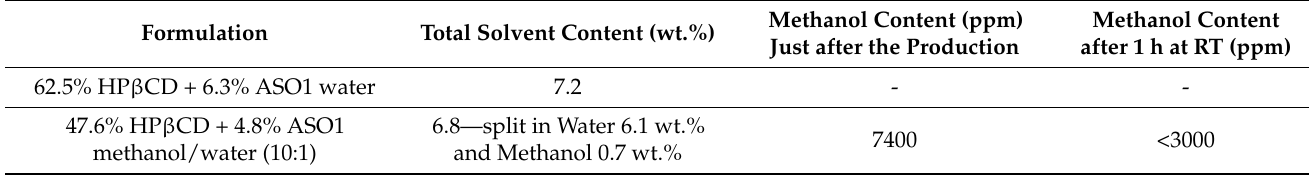
Table 3. Residual solvent content of the electrospun formulations.